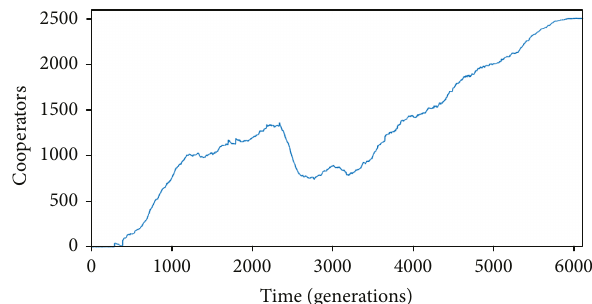
Figure 15: Evolution of the frequency of cooperators in a 50 × 50 system of defectors, where cooperation arises by silent mutations of gene Y = S